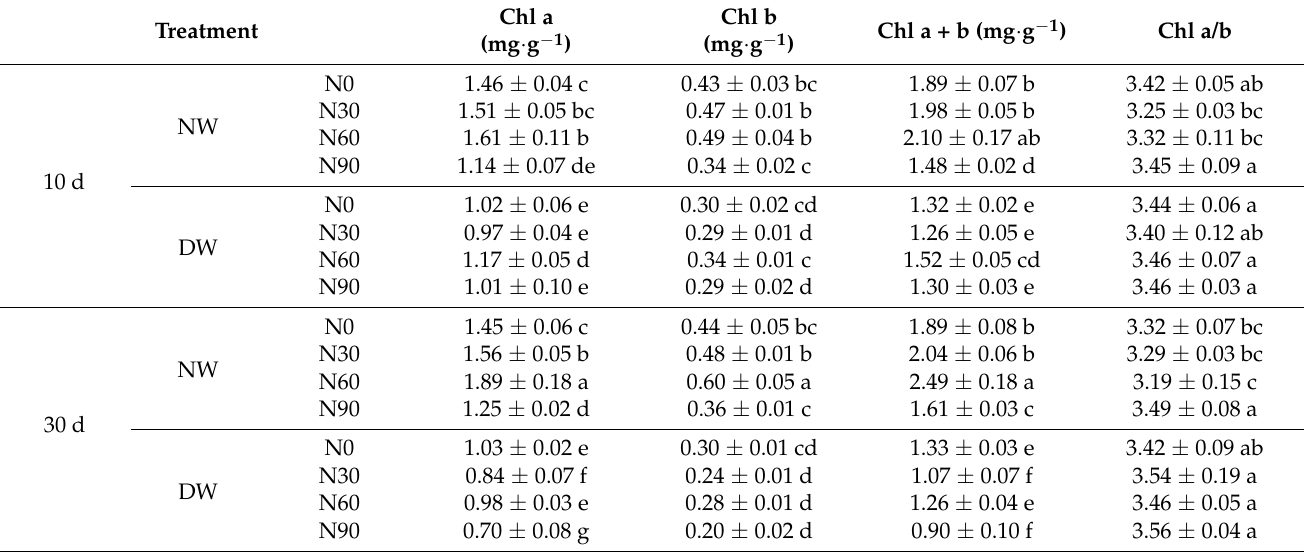
Table 1. Effect of water supply and nitrogen deposition level on the chlorophyll a and b content of Bretschneidera sinensis seedlings.